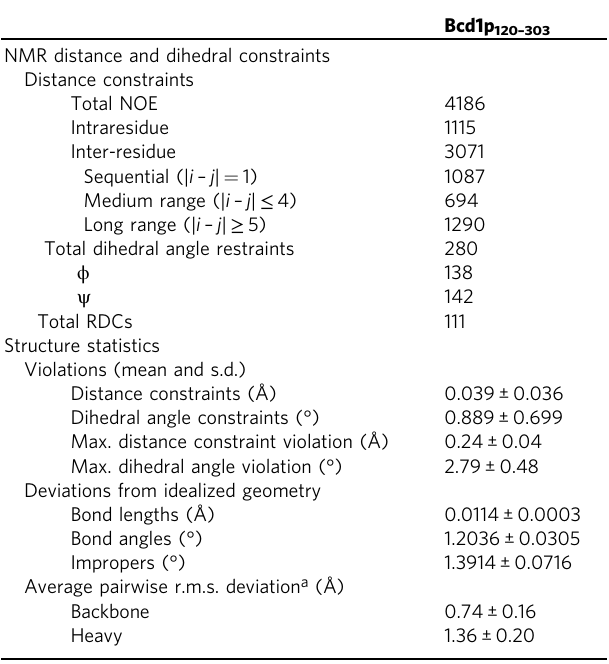
Table 1 NMR and re fi nement statistics for protein